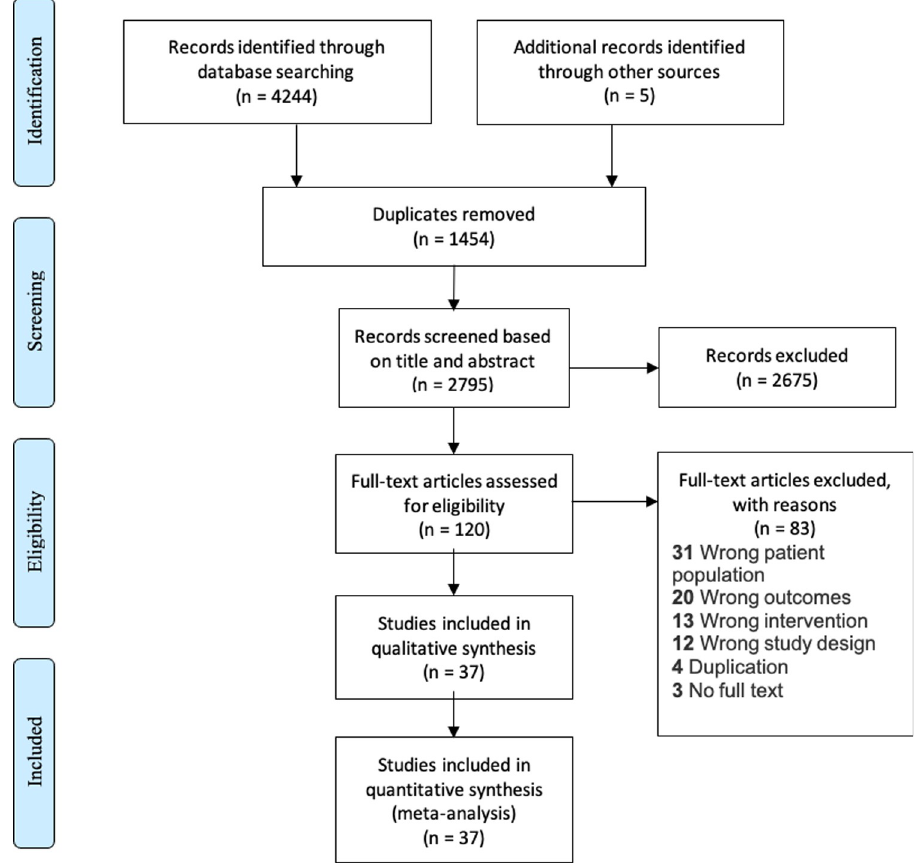
Fig 2. PRISMA diagram of included